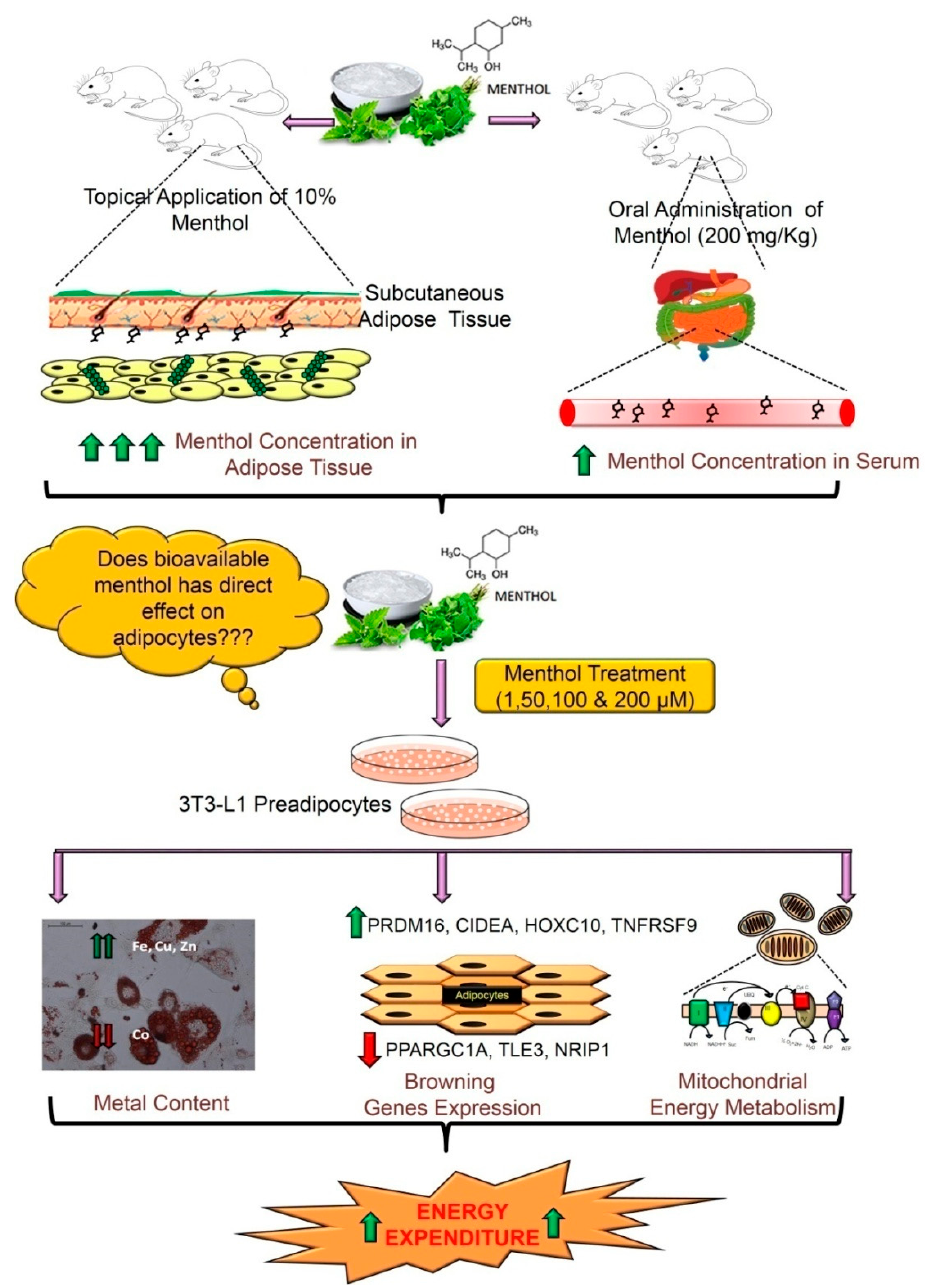
Figure 7. Summary of e ff ect of bioavailable menthol on adipose tissue using in-vitro model. Using the bioavailable concentrations of menthol in adipose tissue and serum upon oral / topical administration, the dosage were decided for in-vitro menthol treatment and e ff ect was checked on expression of genes involved in adipogenesis, browning , mitochondrial biogenesis and energy expenditure. The results showed enhanced energy expenditure markers, which indicates improved negative energy balance leading to reduction in obese